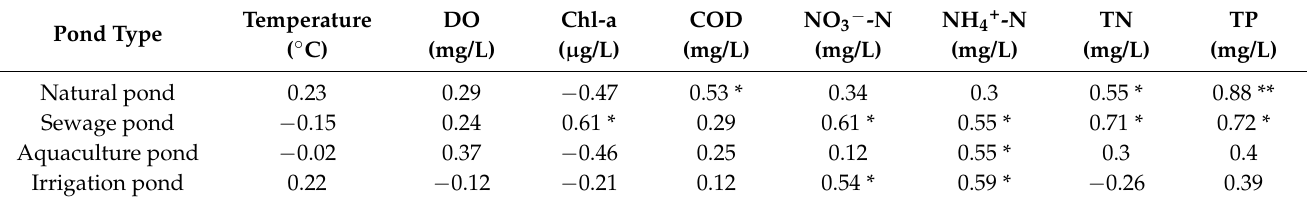
Table 2. Correlations between monthly DOC concentration and environment